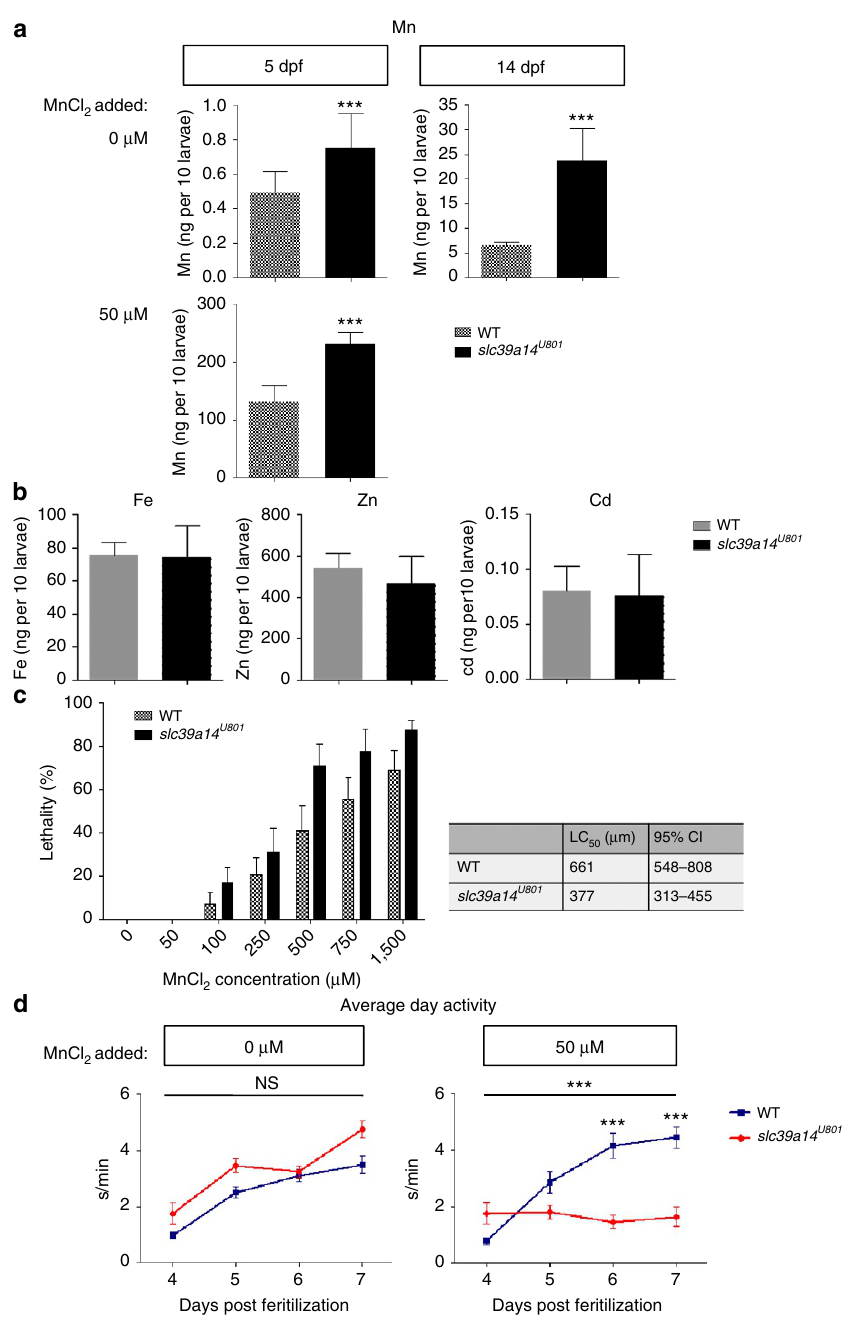
Figure 6 | Loss of slc39a14 function in zebrafish leads to increased Mn accumulation and sensitivity as well as impaired locomotor behaviour. ( a ) Mn levels assessed in homozygous s lc39a14 U801 and wild-type (WT) larvae show that mutant larvae have significantly raised Mn levels at 5 dpf ( P ¼ 0.001) and 14 dpf ( P ¼ 0.0002), and Mn accumulation on MnCl 2 exposure (50 m M from 2 dpf) is significantly higher in mutant compared with WT larvae ( P ¼ 0.000) at 5 dpf. Measurements were taken from pools of 10 larvae. Data are presented as means ± s.d. from a minimum of five independent experiments. Statistical analysis was performed using Student’s two-tailed t -test (*** P o 0.001). ( b ) Graph showing Fe, Zn and Cd levels in 14 dpf mutant and WT larvae. Levels of all three metals are not significantly different between the two groups ( P ¼ 0.906 [Fe], P ¼ 0.257 [Zn], P ¼ 0.834 [Cd]). Measurements were taken from pools of 10 larvae. Data are presented as means ± s.d. from five independent experiments. Statistical analysis was performed using Student’s two-tailed t -test (NS, not significant). ( c ) Graph presenting the lethality in homozygous s lc39a14 U801 and WT larvae at 5 dpf on MnCl 2 exposure between 2 and 5 dpf. Median lethal concentration (LC 50 ) of MnCl 2 determined by Probit regression analysis was 661 m M for WT (95% confidence interval (CI) 548–808 m M) and 377 m M (95% CI 313–455 m M) for mutant fish. Data are presented as means ± s.e.m. from nine